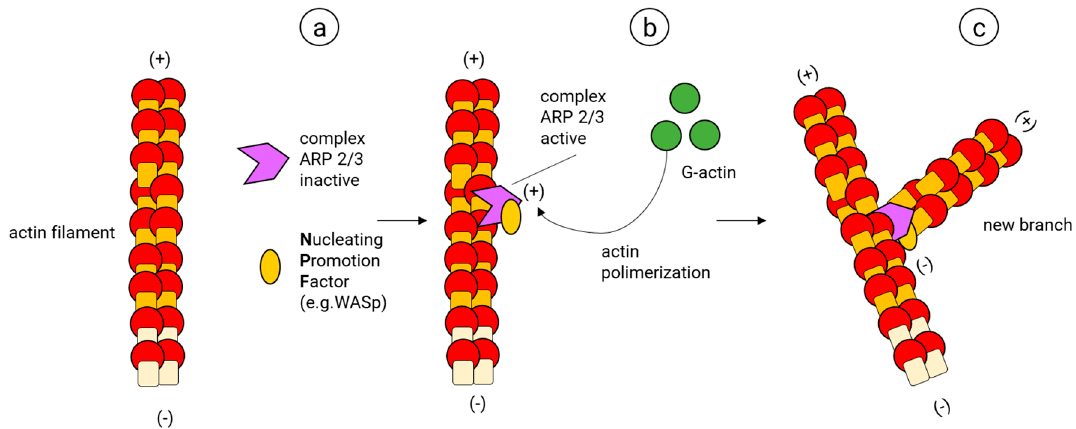
Figure 6. Beginning of the branches of the actin filaments by the ARP2 / 3 complex. The ARP2 / 3 complex binds to a preformed actin filament in the presence of an activating protein near to the plus end of the actin filament and then it initiates the formation of the branches.